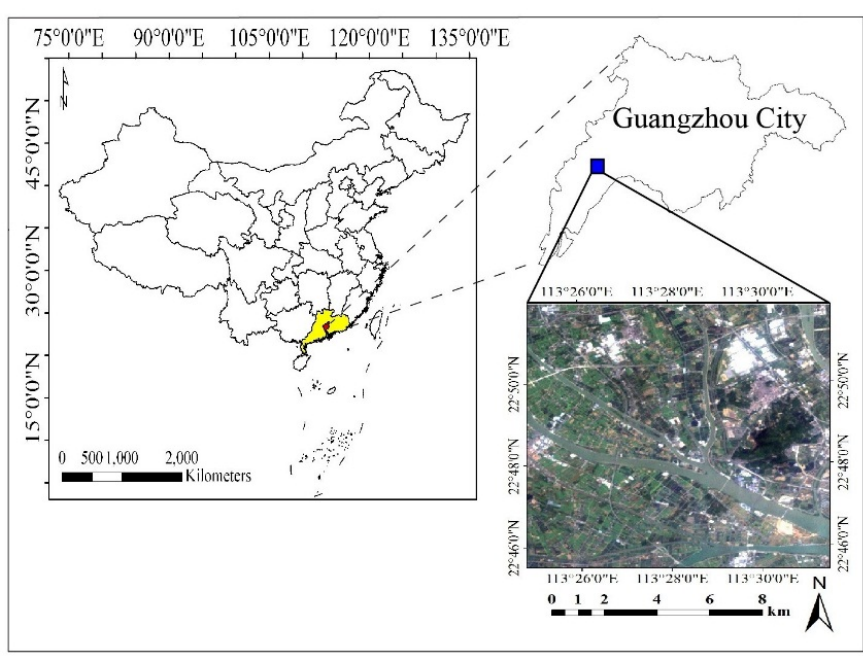
Figure 3. Location of the study area.